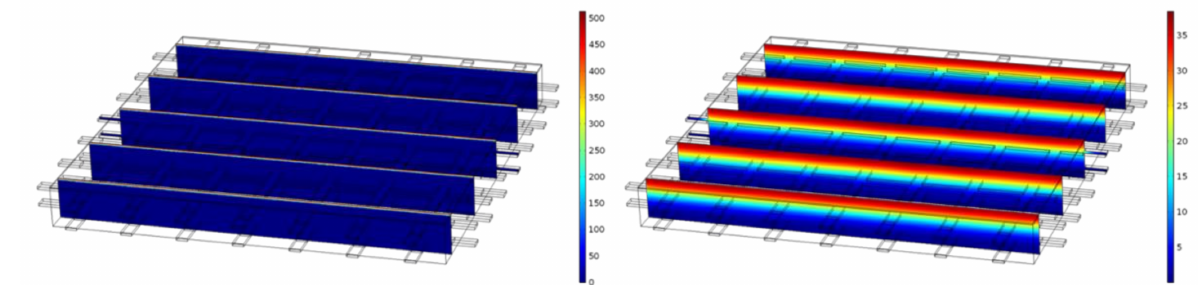
Figure 12. A 3D model of the FEM solution for the NaCl concentration for 0 V at t = 0 d (left) and t = 650 d (right).